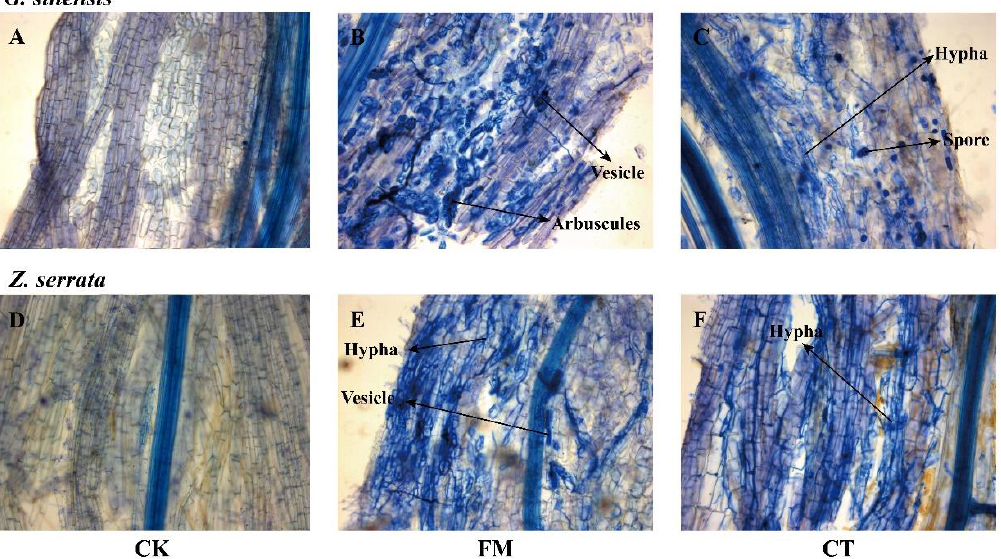
Figure 1. Variations in mycorrhizal colonization status between treatments and species. ( A )mycorrhizal colonization statu of G. sinensis CK treatment [29]; ( B ) mycorrhizal colonization statu of G. sinensis FM treatment; ( C) mycorrhizal colonization statu of G. sinensis CT treatment [29]; ( D ) mycorrhizal colonization statu of Z. serrata CK treatment; ( E ) mycorrhizal colonization statu of Z. serrata FM treatment; ( F ) mycorrhizal colonization statu of Z. serrata CT treatment. With higher salt concentrations, the mycorrhizal dependence of the G. sinensis FM treatment gradually increased, while the mycorrhizal dependence of the CT treatment initially increased and then decreased. Among them, when the salt concentrations were 100 mM and 150 mM, mycorrhizal dependence under the FM treatment was increased by 9.0% and 8.4%, respectively ( p < 0.05), compared with 0 mM. When the salt concentration was 100 mM, the mycorrhizal dependence of the CT treatment was higher than that under other salt concentrations ( p < 0.05) (Figure 2C). In contrast to the FM treatment of Z. serrata , mycorrhizal dependence under the CT treatment decreased under higher salt concentrations. When the salt concentration was higher than or equal to 100 mM, the mycorrhizal dependence of the FM treatment was higher than that of the CT treatment ( p < 0.05) (Figure